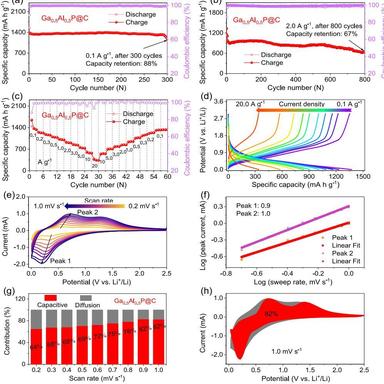
(a and b) Long cycle performance of the Ga0.5Al0.5P @C composite at 100 mA g1 and 2,000 mA g1 . (c) Rate performance. (d) GCD profiles at different current density. (e) CV curves at various scan rates, from 0.2 to 1.0 mV s1 after activating at 0.1 mV s1 . (f) b-values at peak 1 and peak 2, respectively. (g) Separation of contributions from capacitive and diffusion-controlled capacities at different sweep rates. (h) Capacitive and diffusion-controlled contribution at 1.0 mV s1 .